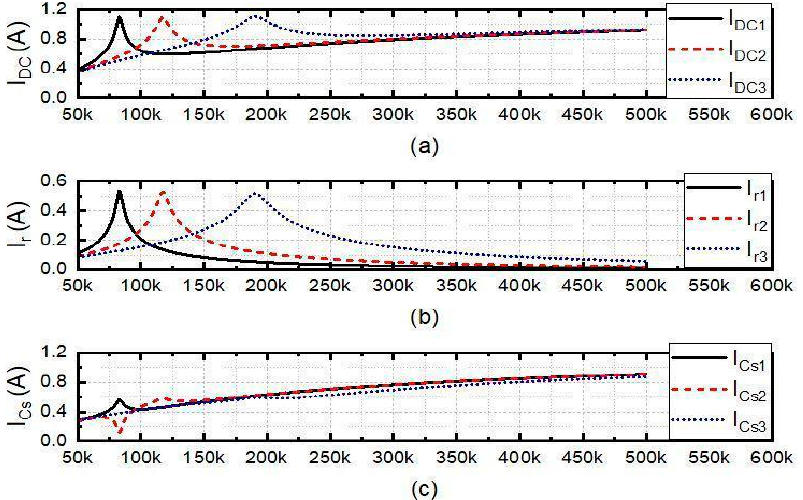
Figure 8. Variation of current through input side, MOSFET, and resonant network for different resonant inductor values.